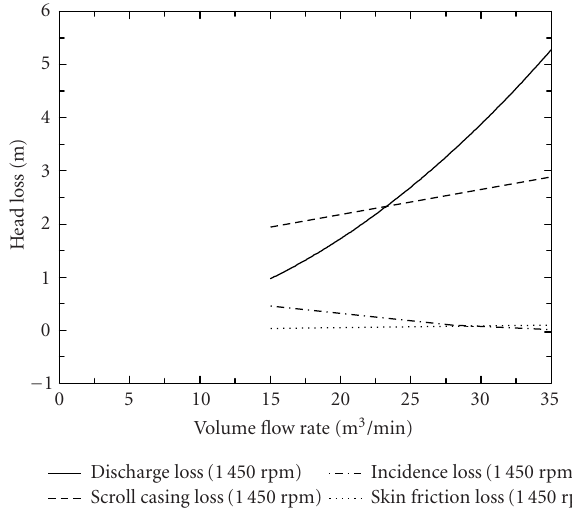
Figure 6: Loss distributions in a cross-flow fan over the normal operating